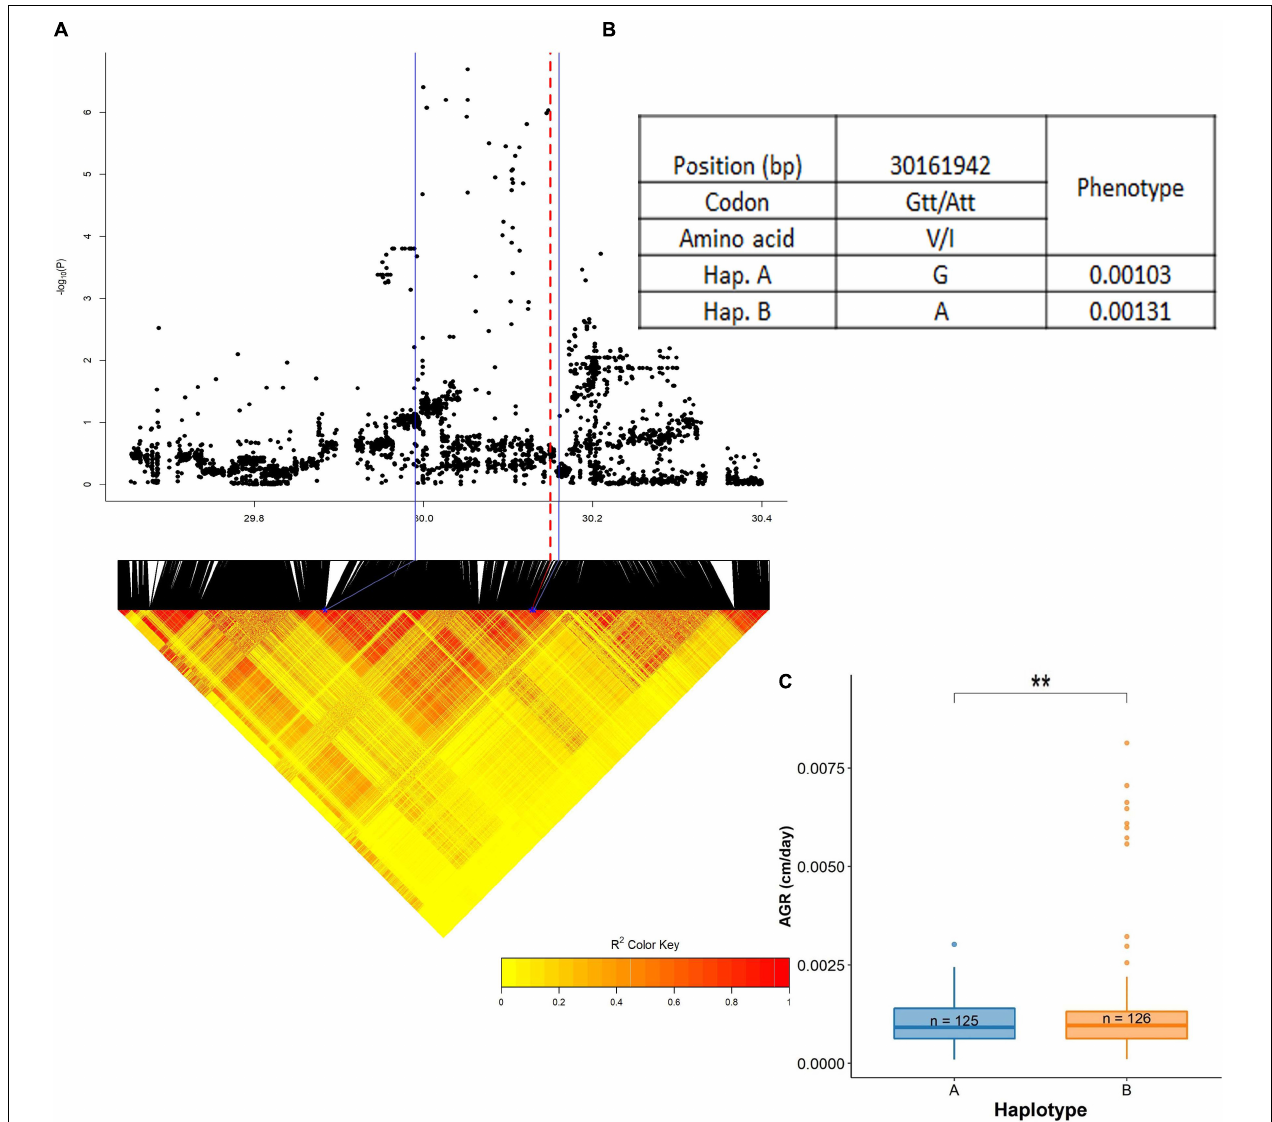
FIGURE 9 | Significant association for absolute root growth on chromosome 4- 29.99–30.16 Mb. (A) Local Manhattan plot (top) and LD heat map (bottom) of QTL on chromosome 4, the blue solid line represents the candidate regions and red dash line represents the candidate gene LOC_Os04g50950 ( PTR6 ); (B) the synonymous and non-synonymous SNPs in the candidate genes PTR5 and PTR6 significantly associated with absolute root growth, and amino acid variations; and (C) variation in absolute root growth indicated haplotypes of PTR5 and PTR6 . Significance level; * p < 0.05, ** p < 0.01, *** p < 0.001, **** p < 0.0001. ns, non